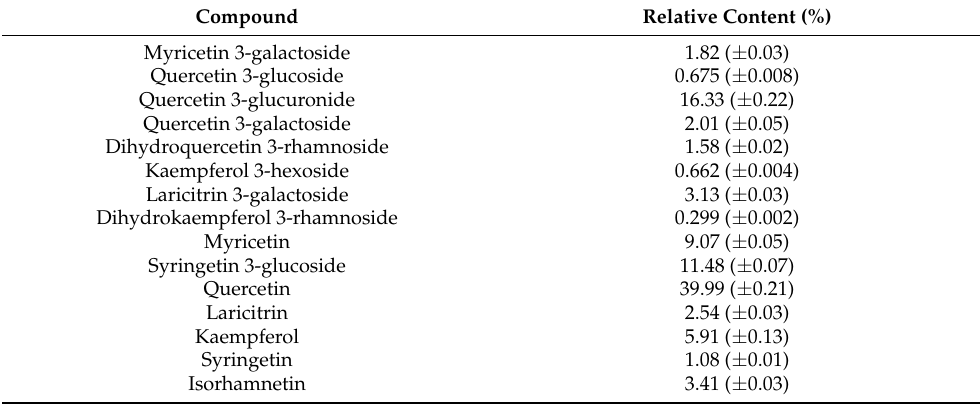
Table 10. Relative content of flavonols in the EtOH-H 2 O extract. The % was determined by measuring